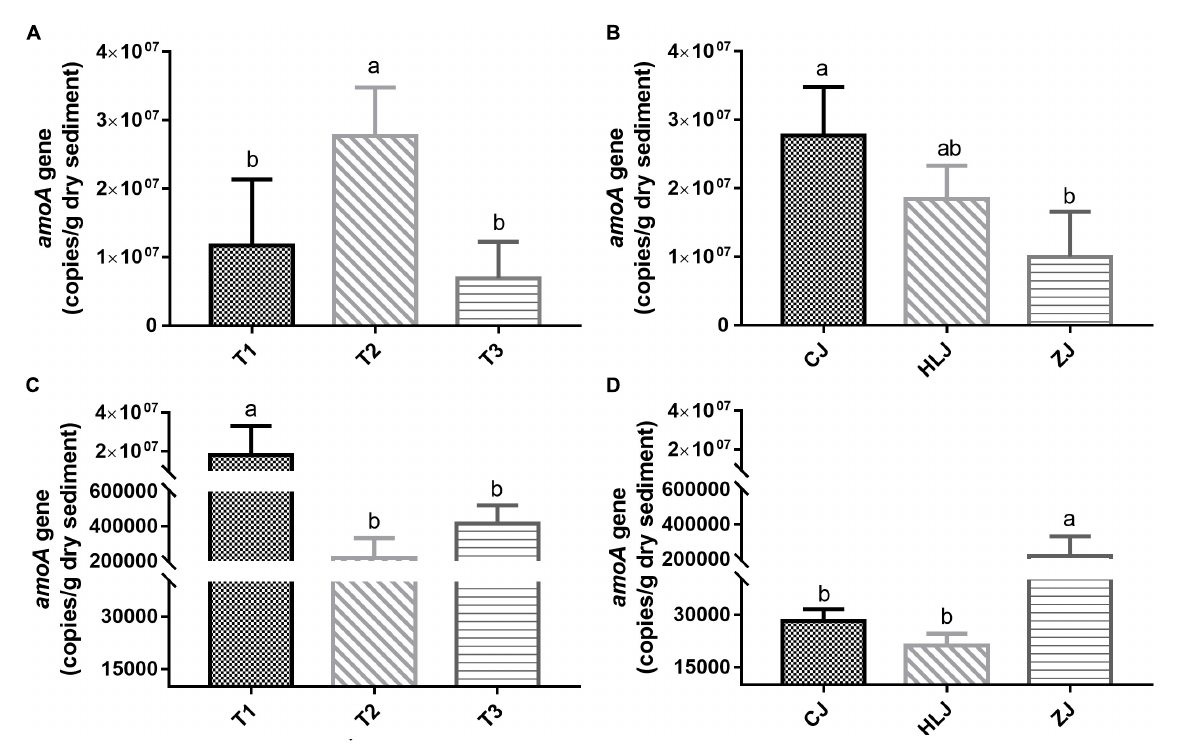
FIGURE1 Numbers of ammonia-oxidizing archaea (AOA) amoA gene copies in Changjiang (CJ) ponds (A) and ammonia-oxidizing bacteria (AOB) in Zhujiang (ZJ) ponds (C) at different sampling times, and AOA (B) and AOB (D) copies in different sampling areas at sampling time T2. The error bar denotes standard error among the samples, and different letters above bars indicate significant difference ( p < 0.05, n = 3). Only ponds with significant differences are presented.